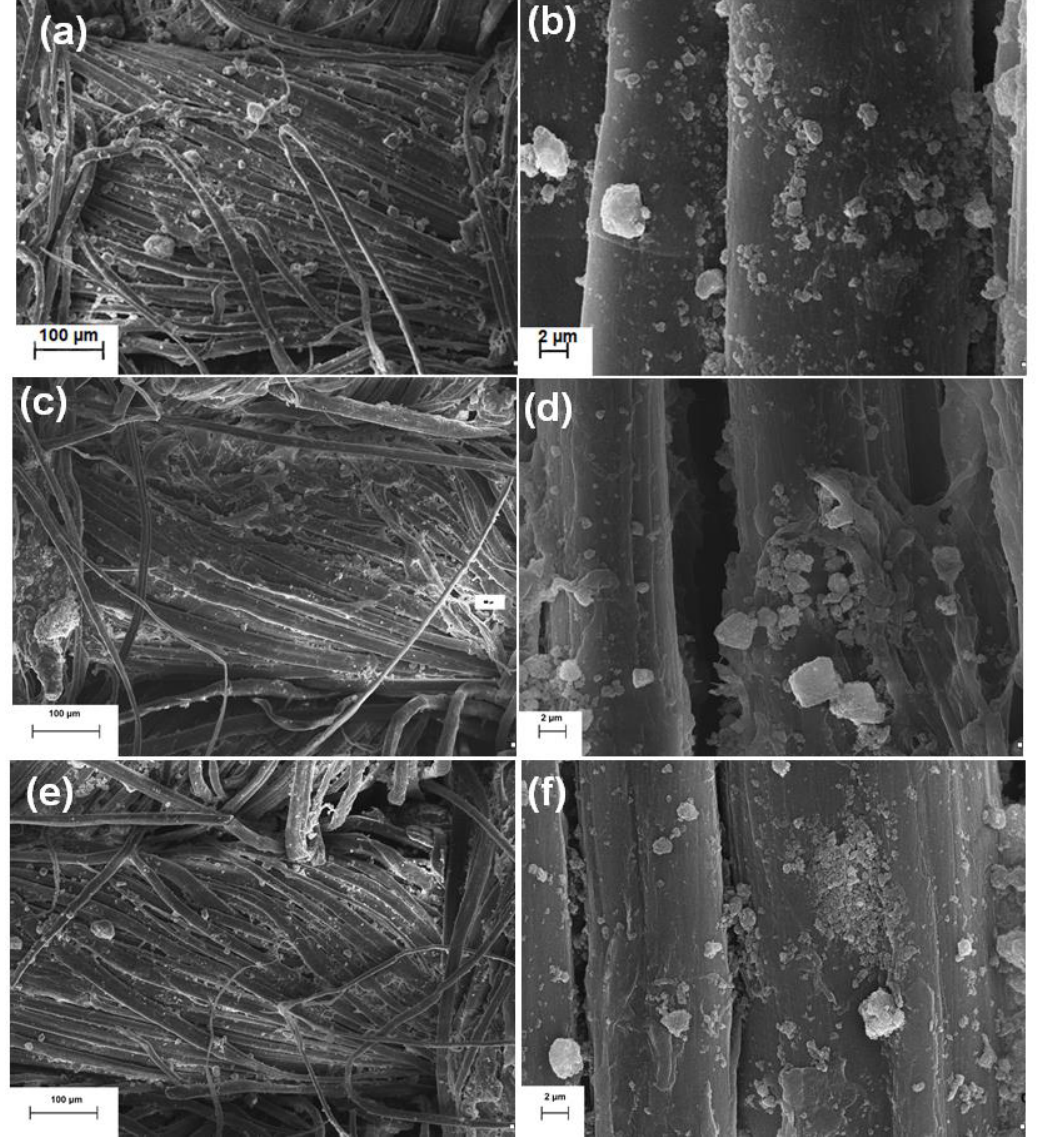
Figure 2. Scanning electron micrographs of: ( a , b ) linen woven fabric after alkaline treatment and dip-coating with 5% wt. of CuO-SiO 2 , ( c , d ) linen woven fabric after enzymatic treatment with 2.5 U/g of laccase and dip-coating with 5% wt. of CuO-SiO 2 , ( e , f ) linen woven fabric after enzymatic treatment with 5.0 U/g of laccase and dip-coating with 5% wt. of CuO-SiO 2 .